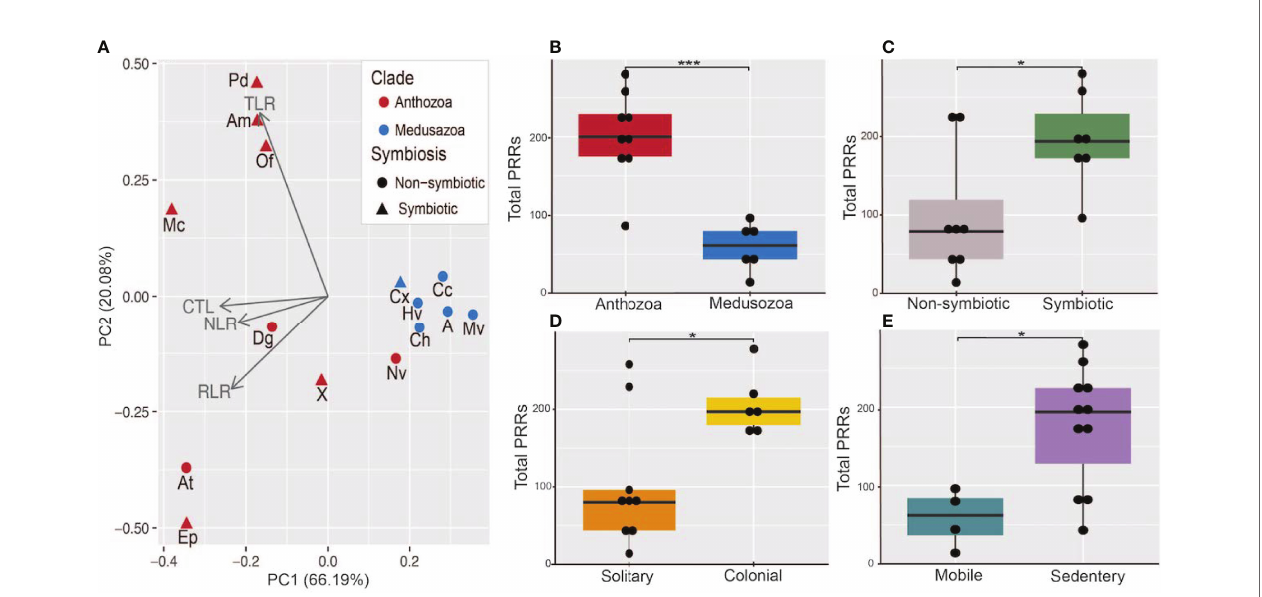
FIGURE 4 | (A) Principal component analysis of total number of PRRs in each category, red points indicate anthozoan species, blue points indicate medusozoan species, triangular points indicate symbiotic species, and circular points represent non-symbiotic species. Aq, Amphimedon queenslandica; Ch, Clytia hemisphaerica; Hv, Hydra vulgaris; Cc, Calavadosi cruxmelitensis; Mv, Morbakka virulenta; A, Aurelia sp.; Cx, Cassiopea xamachana; X, Xenia sp.; Dg, Dendonephthya gigantea; At, Actinia tenebrosa; Ep, Exaiptasia daiphana; Nv, Nematostella vectensis; Am, Acropora millepora; Mc, Montipora capitata; Pd, Pocillopora damicornis. (B – E) Boxplots of